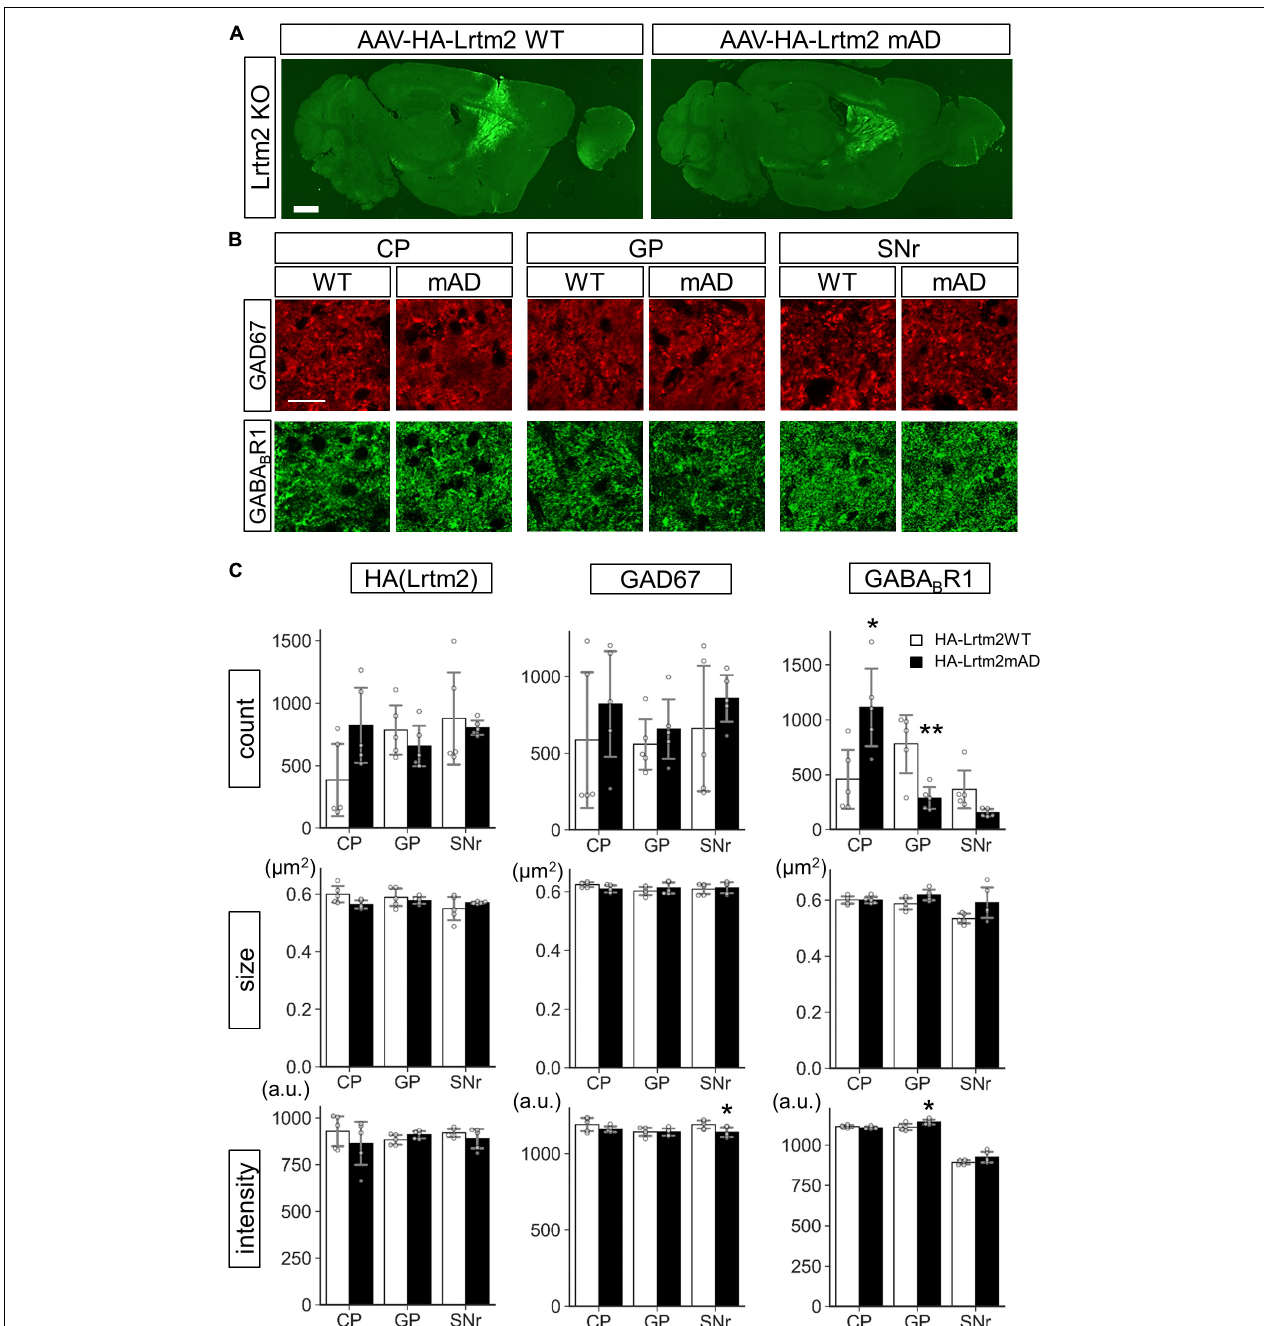
FIGURE 12 | Different GAD67 and GABA B R1 sorting activities of HA-Lrtm2 WT and HA-Lrtm2mAD. HA-Lrtm2 WT or HA-Lrtm2mAD expressing AAV is injected into the right dorsal striatum of Lrtm2 KO mice ( n = 5 mice, 5–27 M-old 2 males and 3 females for each construct). The injected mouse brains are subjected to immunostaining analysis using anti-GAD67 or anti-GABA B R1 antibodies. (A) Representative images. (B) Representative images at higher magnification. Scale bars , 1-mm-thick; 10- µ m-thin. (C) Quantitative analysis. Gray circles indicate individual values, which are the means of two sections per mouse. * p < 0.05, ** p < 0.01, Student’s -test. Error bars ,